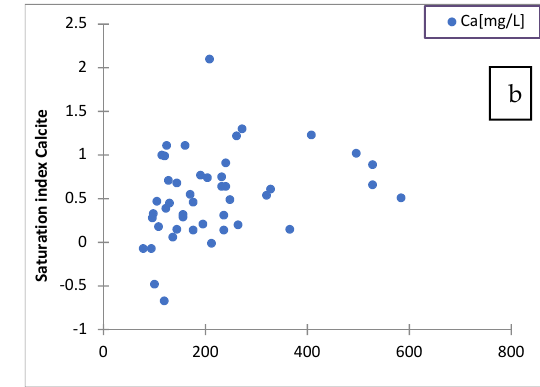
Figure 11. Variation of the different Minerals saturation indexes.